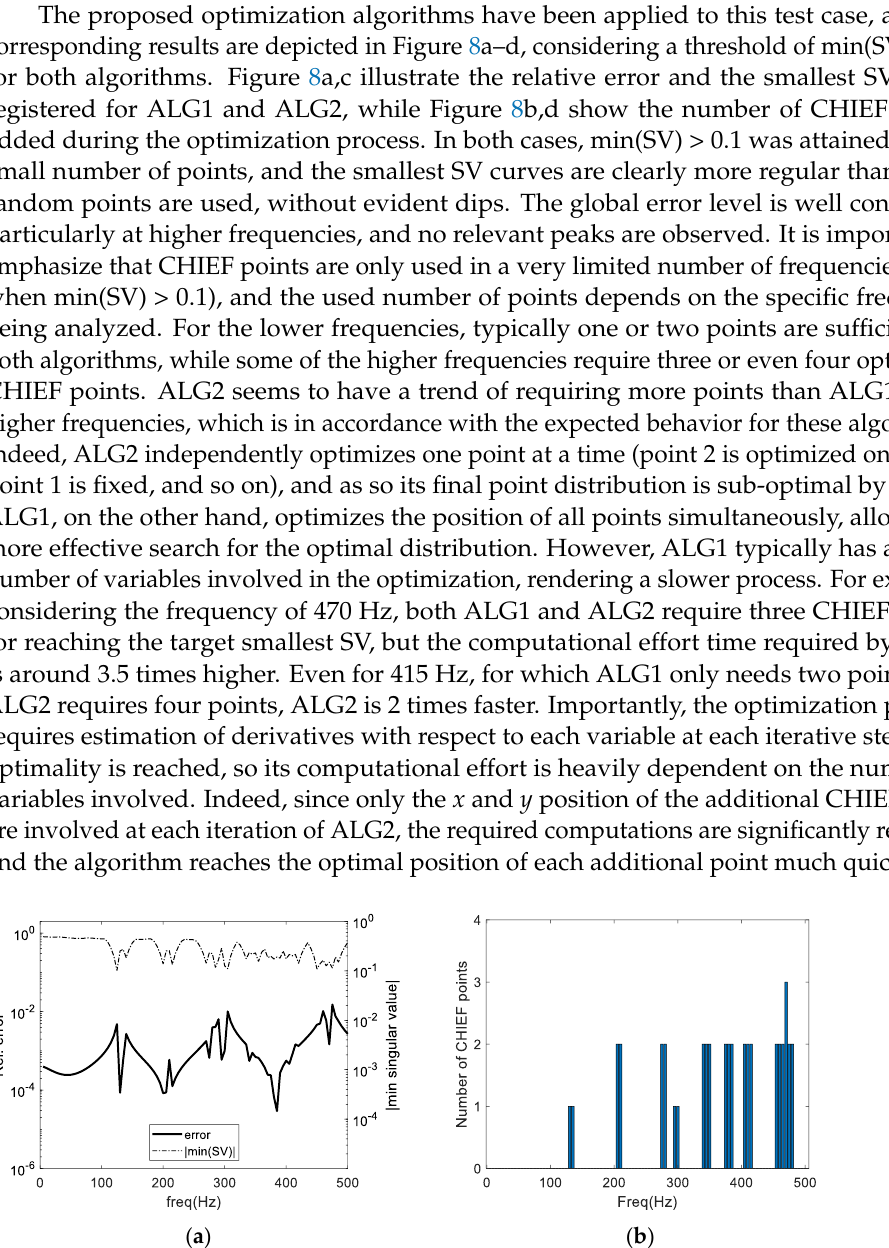
Figure 7. Smallest singular value of the BEM matrix as a function of the position of one CHIEF point: ( a – c ) correspond to frequencies where simultaneously an error peak in the BEM model and a mini- mum in the singular value curve occur (see Figure 4a); ( d – f ) correspond to frequencies where no error peak occurs in the BEM model, but a minimum in the singular value curve occurs.